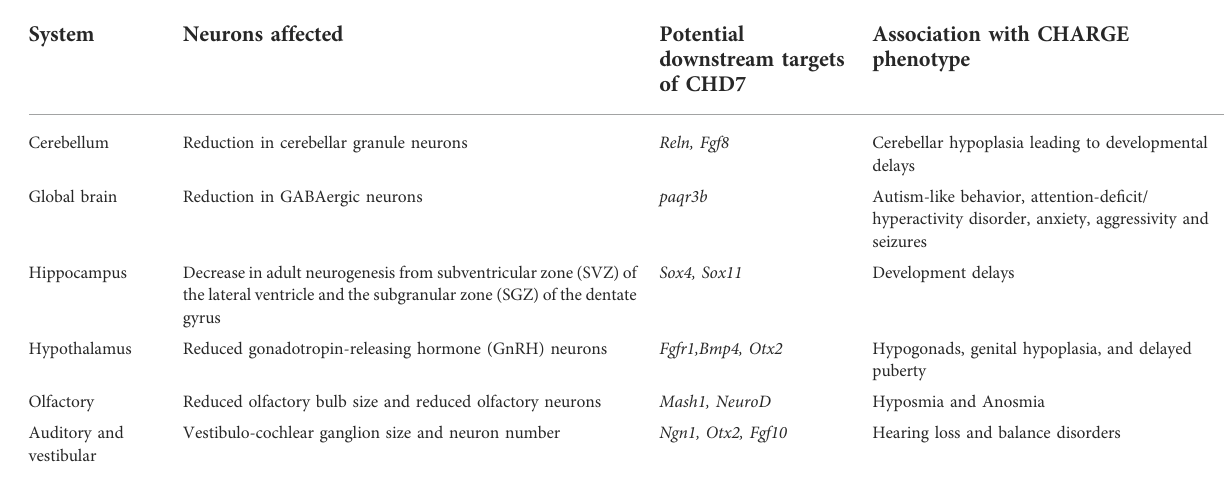
TABLE 3 CHD7 and